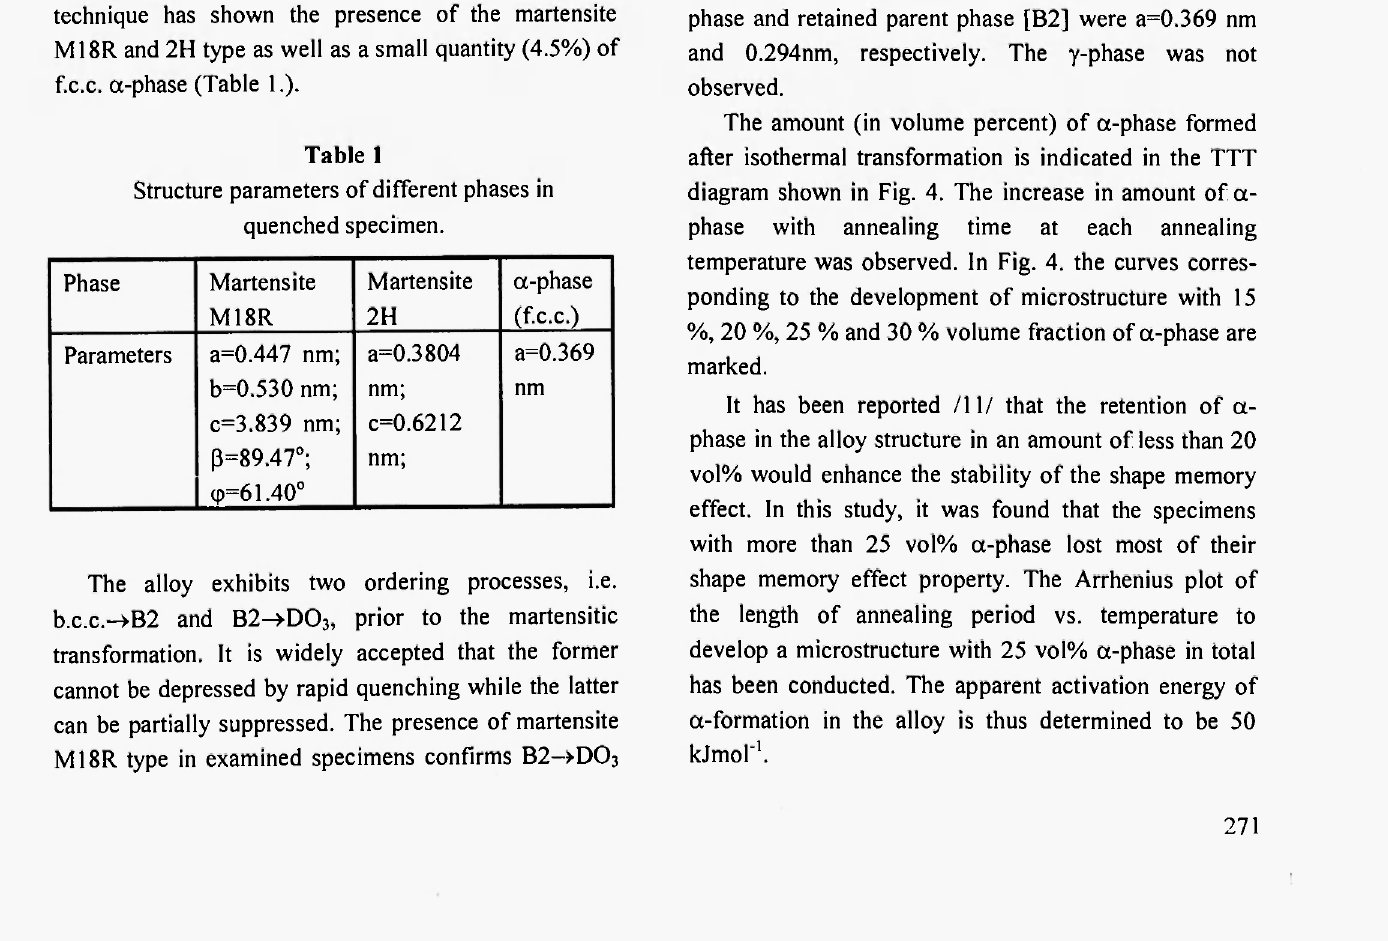
f.c.c. α-phase (Table